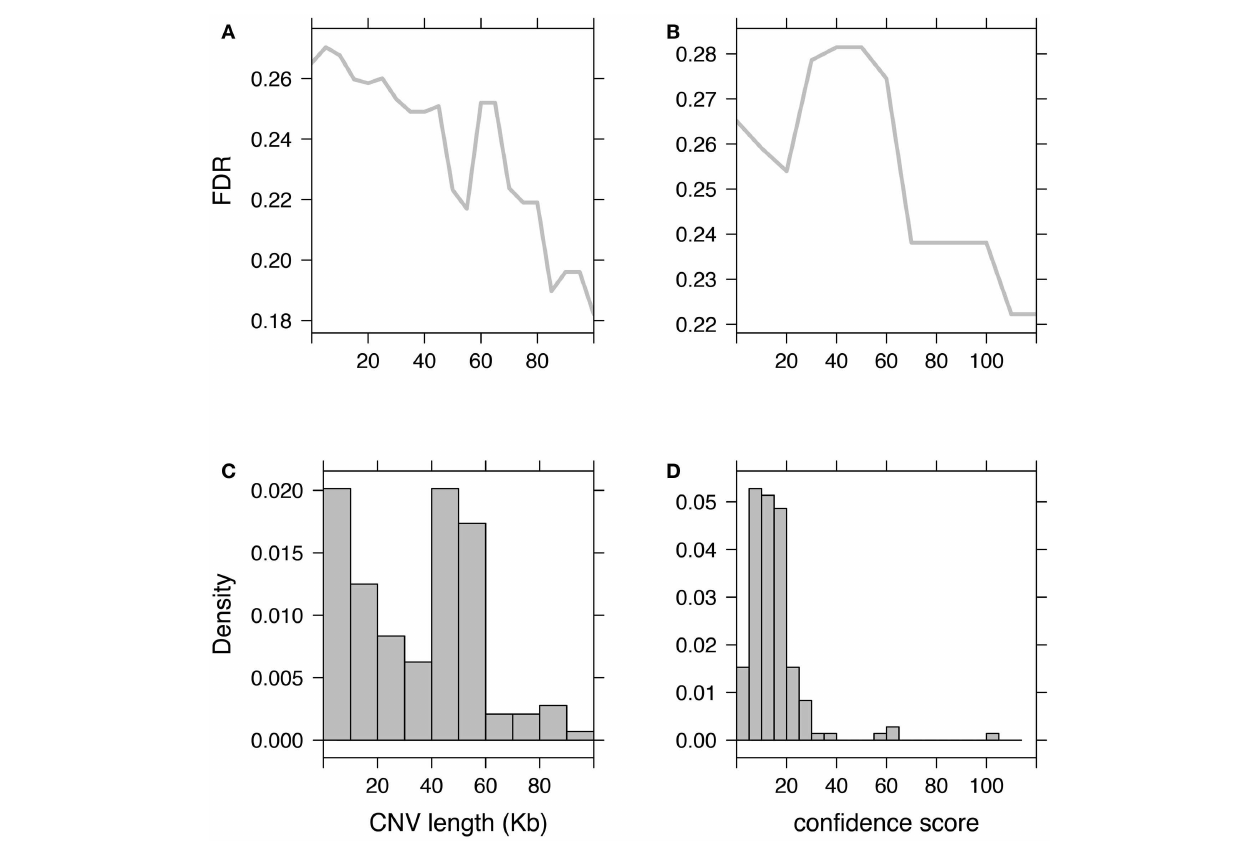
score. Fluctuations in these histograms (such as inversion of the proportion “small CNVs over long CNVs” or “low-confidence over high-confidence CNVs”) are associated with non-monotonic changes in the FDR